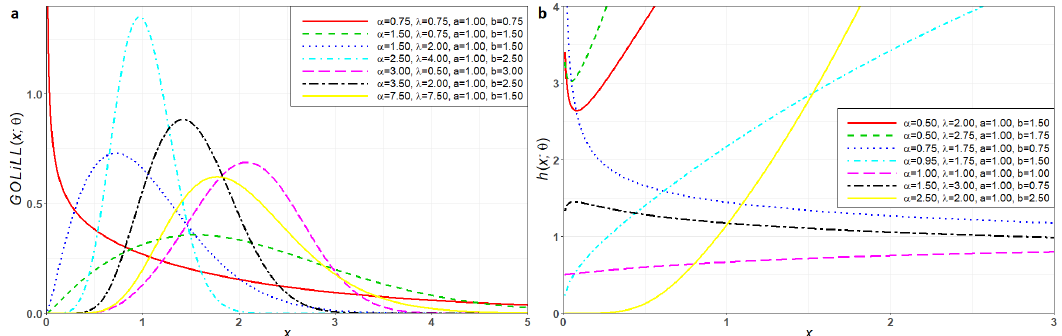
Figure 4 - Plots of the GOLiLL pdf ( a ) and hrf ( b ) for some parameter